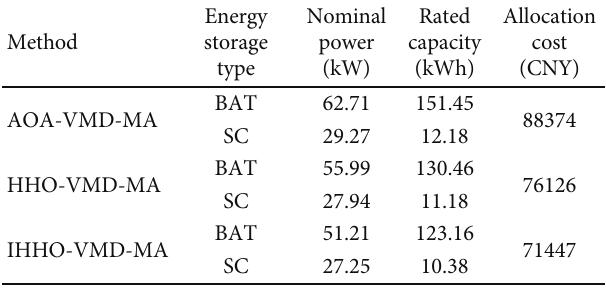
Table 4: The results obtained by con fi guring di ff erent methods.